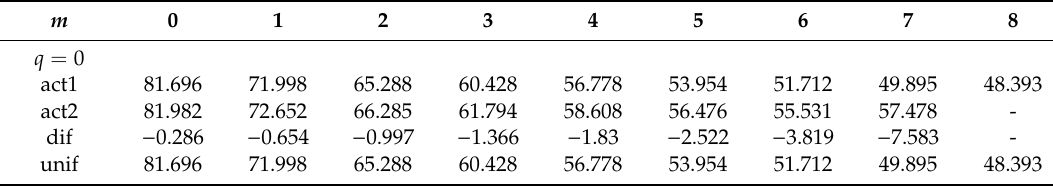
Table 2. Cost di ff erence function ∆ ( q qn , m qn ) and thresholds to trigger group replacements M =